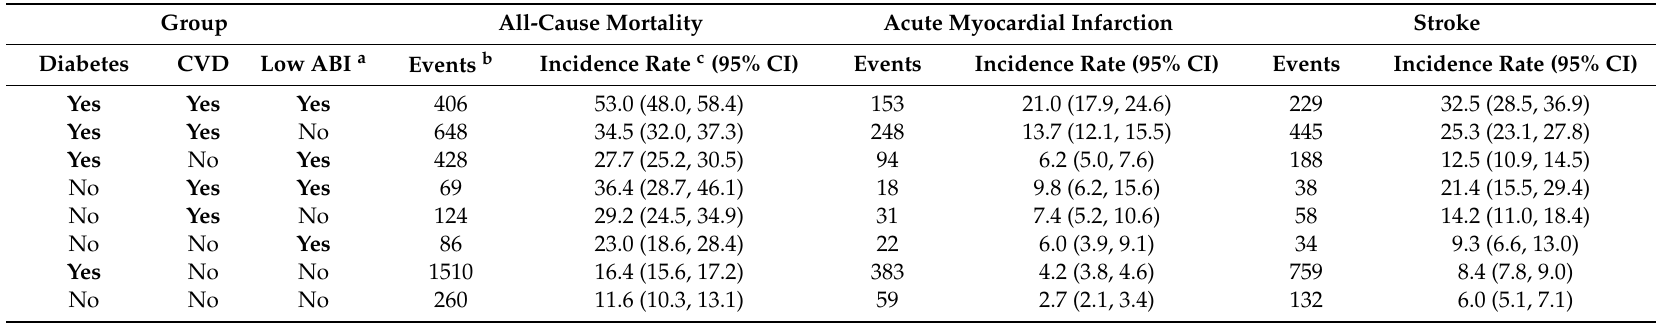
Table A6. Raw incidences of all-cause mortality, acute myocardial infarction, and ischemic stroke by population groups. Complete cases. Group All-Cause Mortality Acute Myocardial Infarction Stroke Diabetes CVD Low ABI a Events b Incidence Rate c (95% CI) Events Incidence Rate (95% CI) Events Incidence Rate (95% CI)